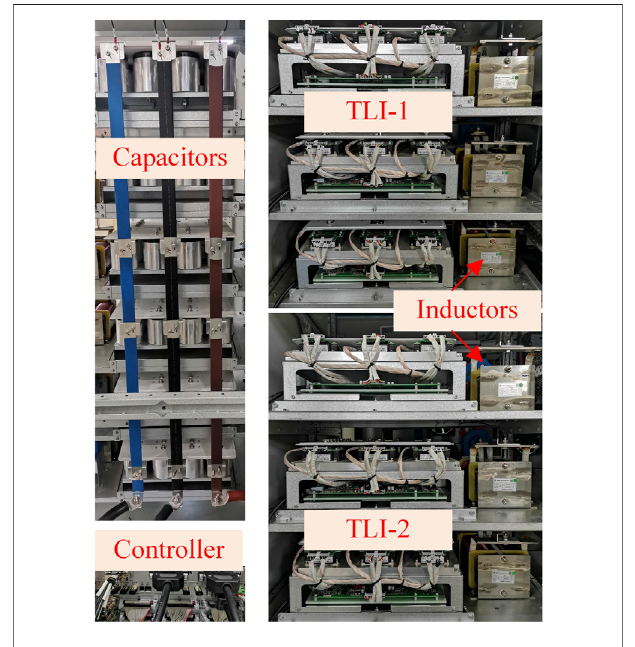
FIGURE 8 | Experiment platform.